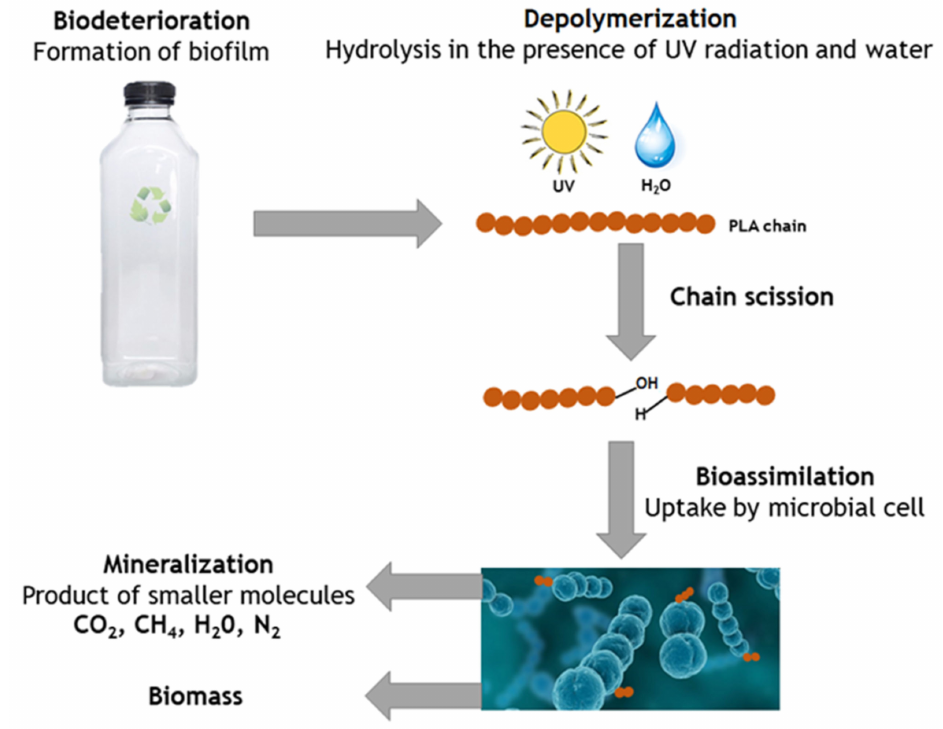
Figure 13. General steps involved in biodegradation of a PLA bottle under composting